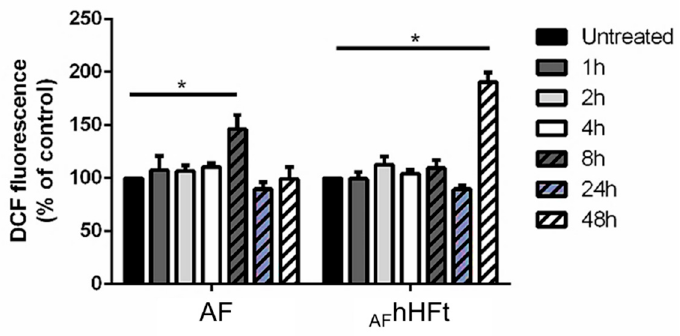
Figure 6. Time-course experiment to determine the effect of AF and AF hHFt on intracellular ROS levels of A431 cells. Cells were incubated in presence of both AF and AF hHFt for 1 h (dark grey bars), 2 h (light grey bars), 4 h (white bars), 8 h (dashed dark grey bars), 24 h (dashed blue bars), 48 h (dashed white bars). Black bars refer to the untreated cells. The fluorescence intensity of the probe is related to the intracellular ROS level and is reported as a percentage of untreated cells (%). Data shown are the means ± S.D. of three independent experiments and * indicates p < 0.05 with respect to untreated cells.